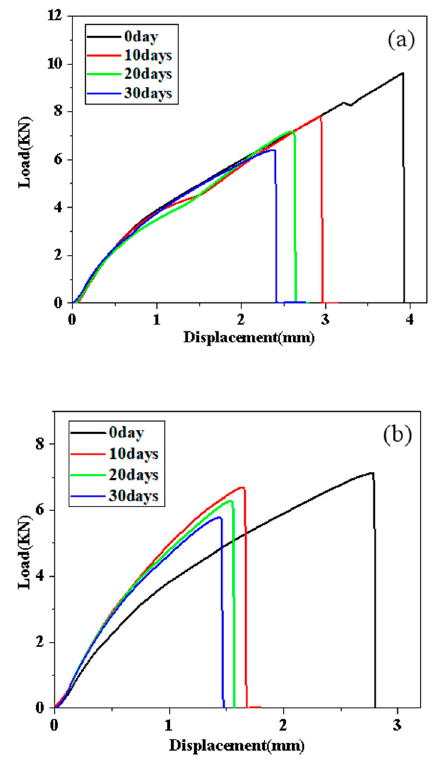
Figure 9. The most representative load displacement curves of different aging stages were obtained: